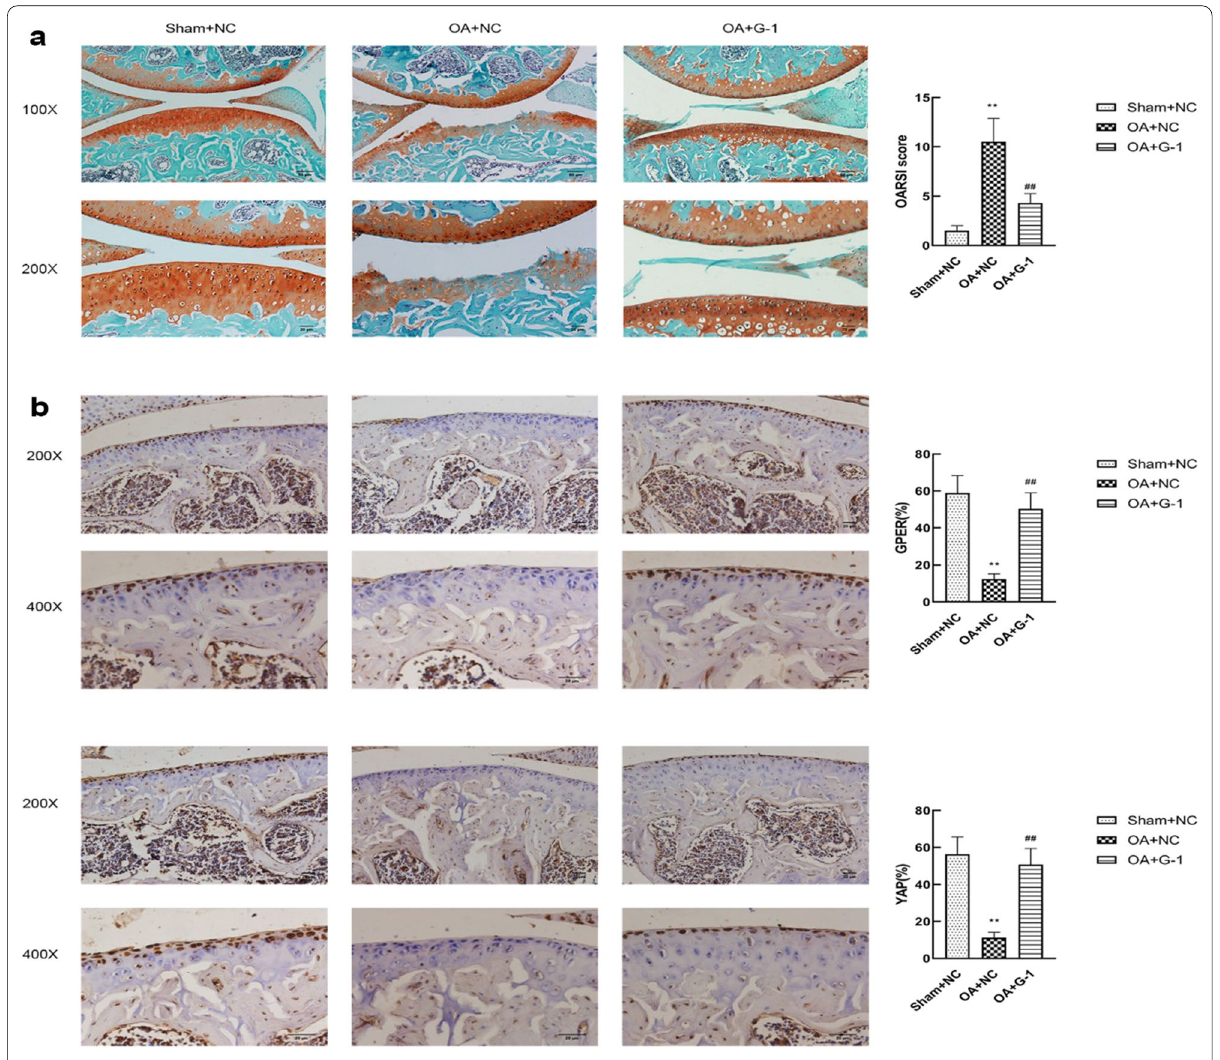
Fig. 6 G-1 activated GPER inhibits articular cartilage degeneration in vivo. a Safranine and Fast Green double staining in each group and associated OARSI scores (n 6). b Immunofluorescence staining GPER, and YAP (n = Sham NC. **P < 0.01, compared with Sham +